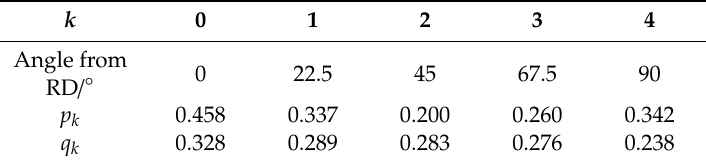
Figure 10. A finite element (FE) model used for inverse analysis. Table 3. Parameters p k and q k for spline yield function.